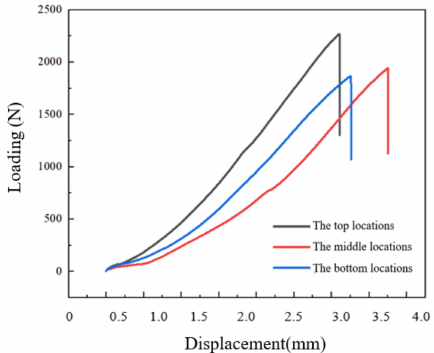
Figure 12. Tensile curves for different locations of deposited samples.